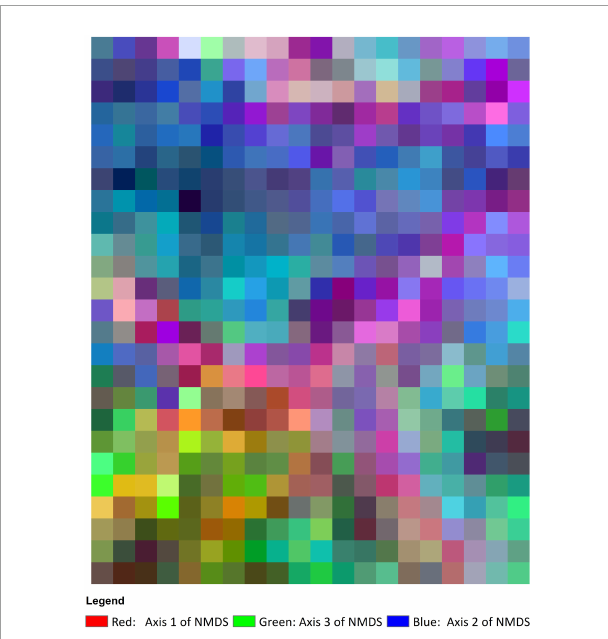
FIGURE7 Species composition map, showing the colours derived from the three axes of the NMDS ordination analysis. The more similar the colour, the more similar the species composition. Cell size is 20 × 20 m.